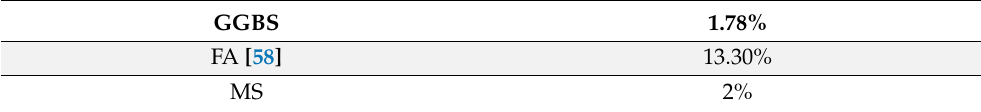
Table 4. Residue on 45 micron sieve for cementitious